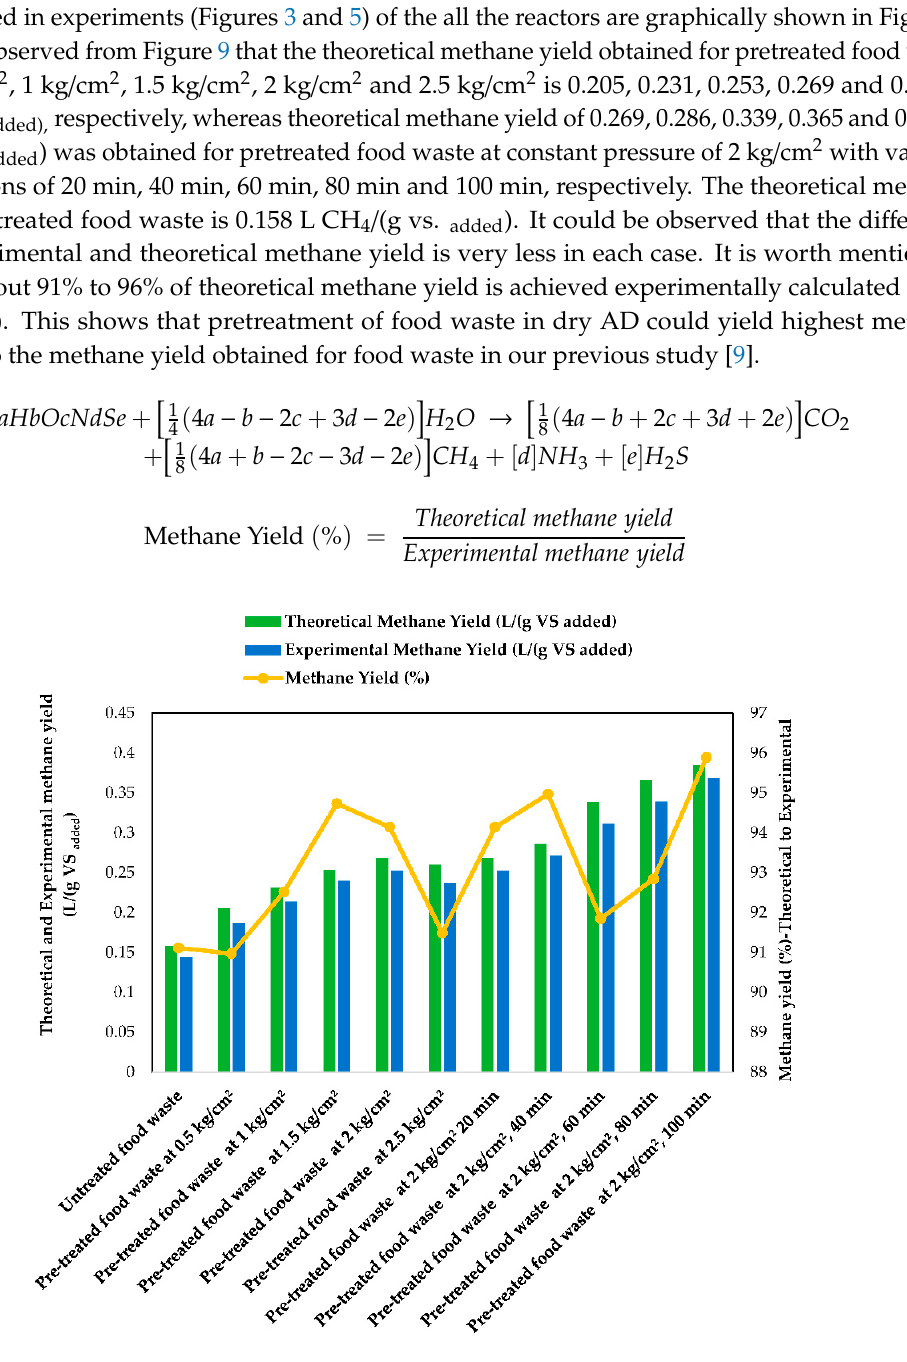
Figure 9. Comparison of theoretical and experimental methane yield.